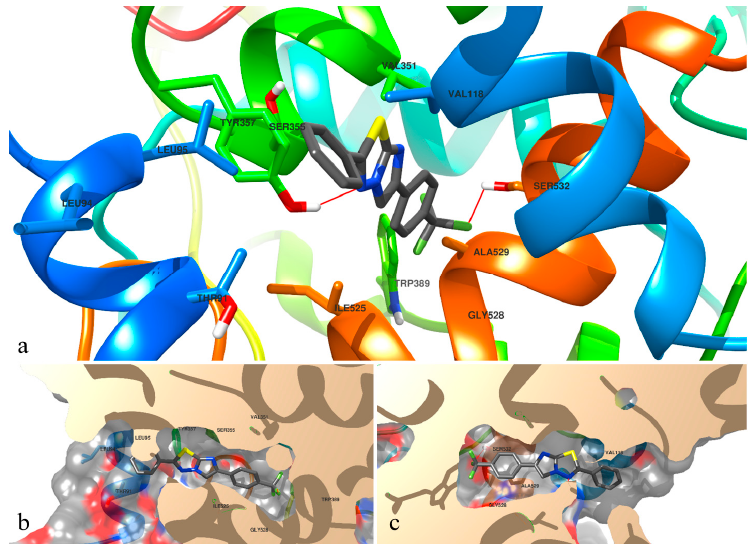
Figure 2. The top binding pose of compound 5c docked to the catalytic site of COX-1. In section ( a ) of